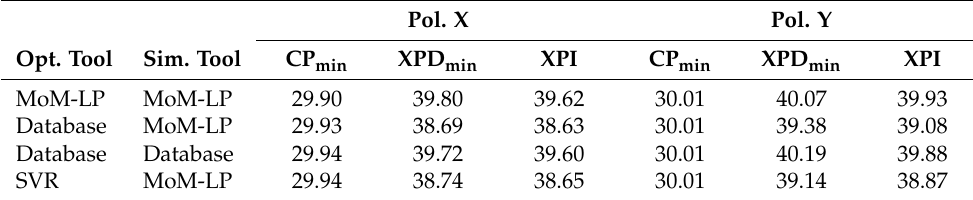
Table 5. Comparison of the figures of merit of a European-coverage pattern after direct layout optimization to improve cross-polarization performance. Three optimizations were carried out with different tools, setting the the goal for XPD min and XPI to 40dB. In all cases, the layout after 16 iterations of the optimization algorithm was simulated with MoM-LP. For optimization with the database, results are also shown when the result was simulated with the database. CP min is in dBi and XPD min and XPI are in dB. Pol. X Pol. Y Opt.